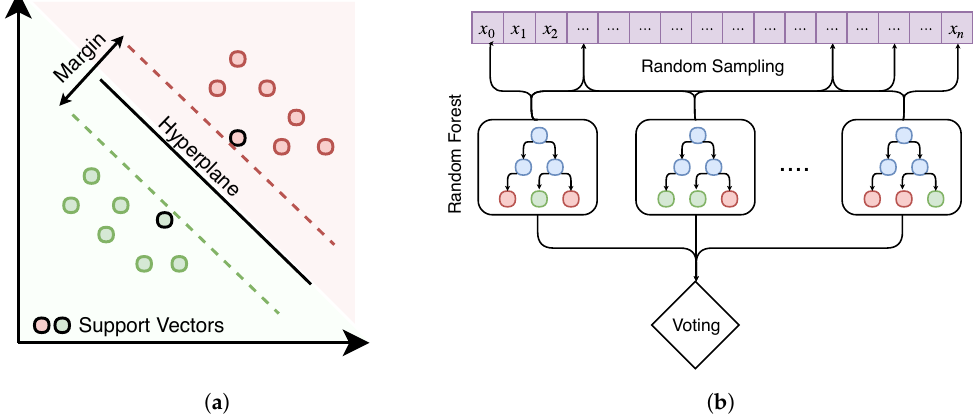
Figure 3. ( a ) Example of an SVM separating two classes with a hyperplane. Optimal class separation is guaranteed by maximizing margin size. ( b ) Example of a random forest with multiple decision trees being trained on random samples from the training